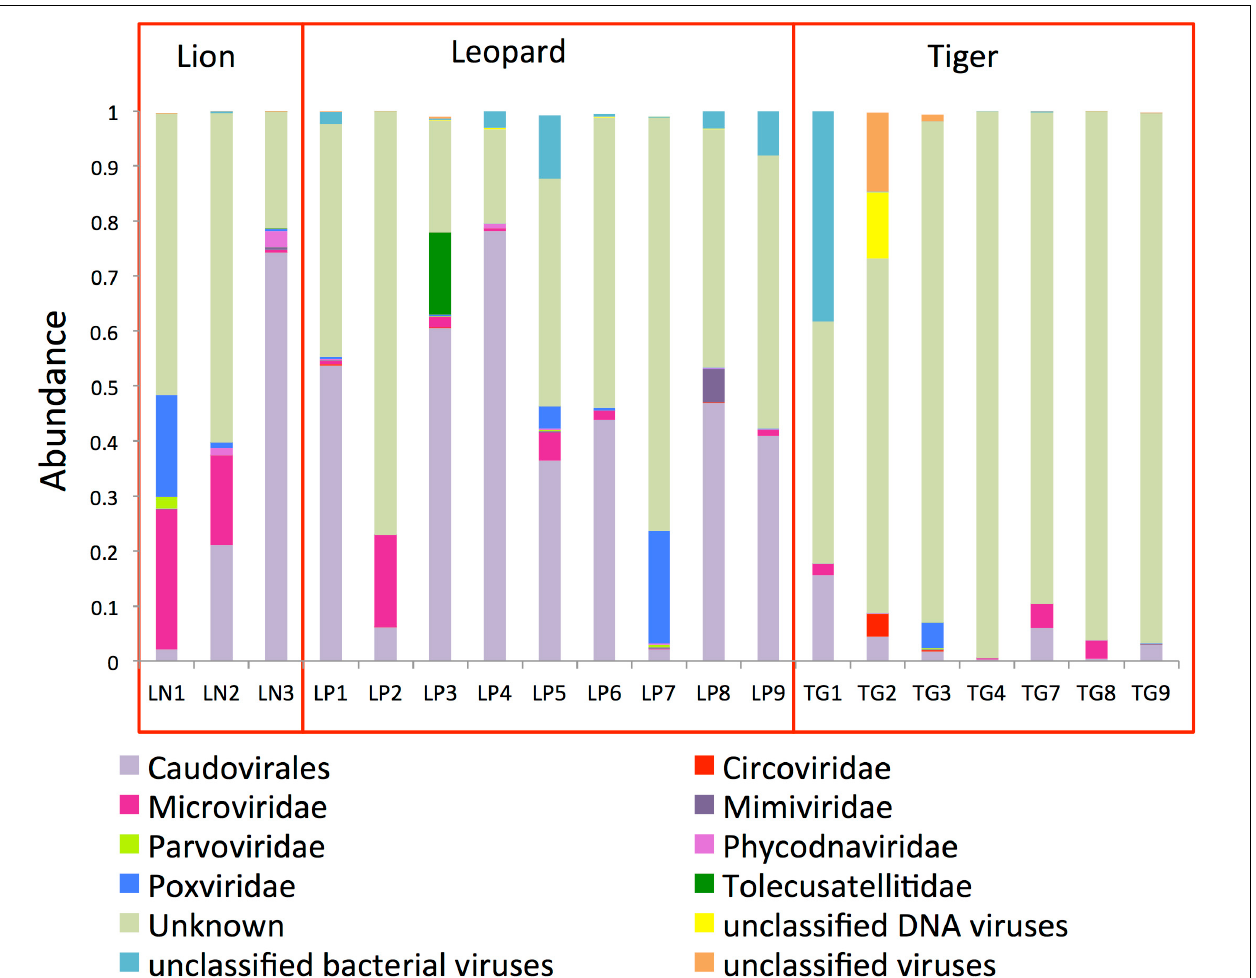
FIGURE 4 | Bar plots showing the topmost abundant virus families present in the Panthera gut microbiome. The families with more than 1% abundance are